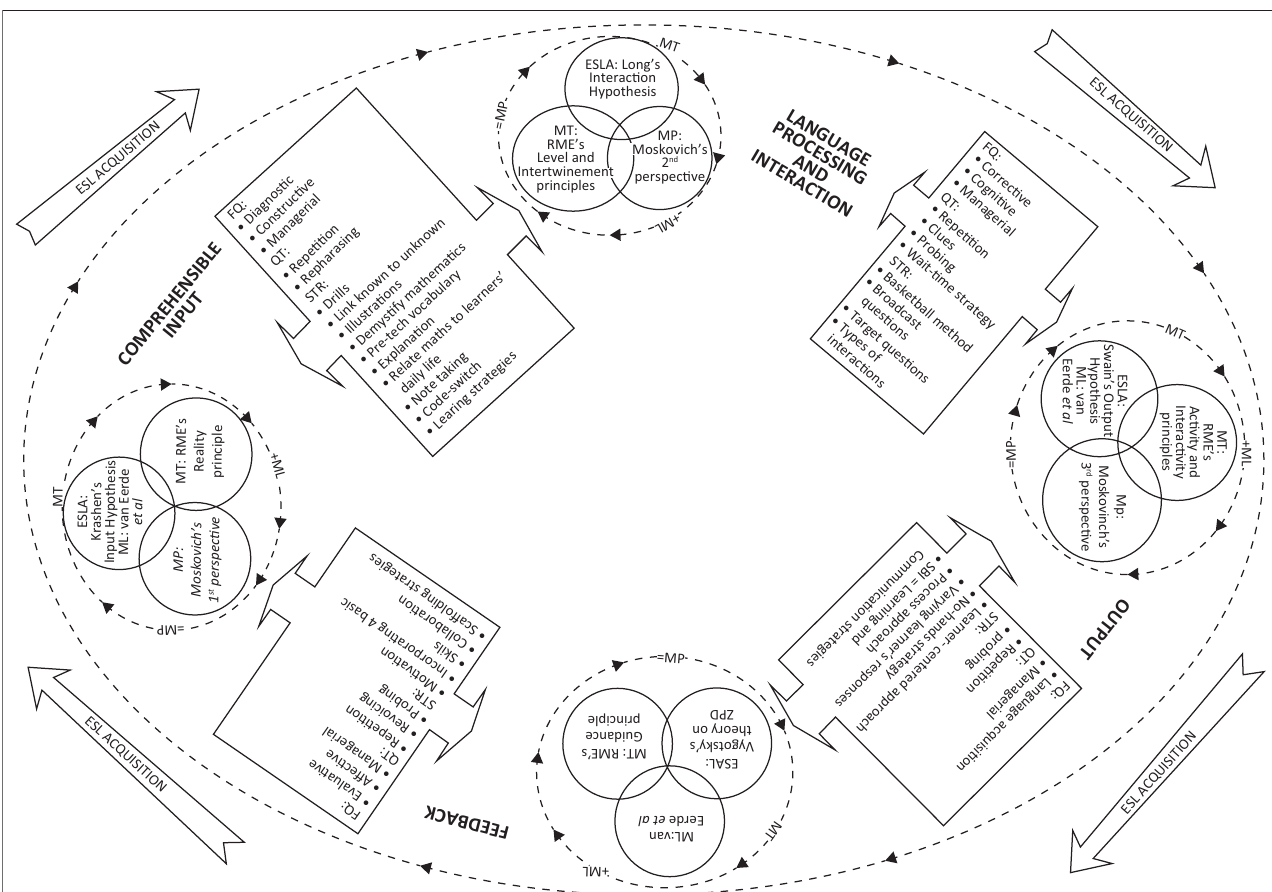
FIGURE 2: A theoretical model to illustrate the simultaneous acquisition of a second language and